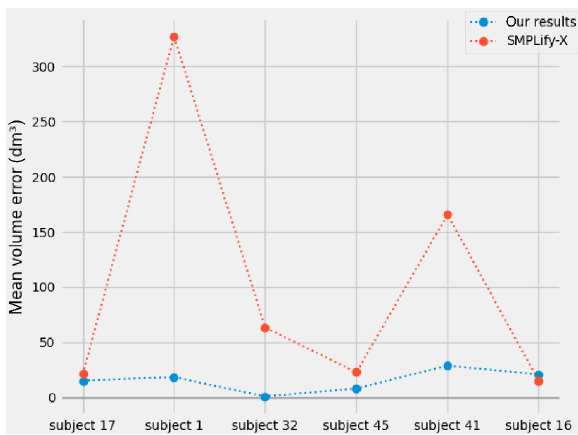
Fig. 8 Mean volume error for Complex Motion, subjects from MoVi.